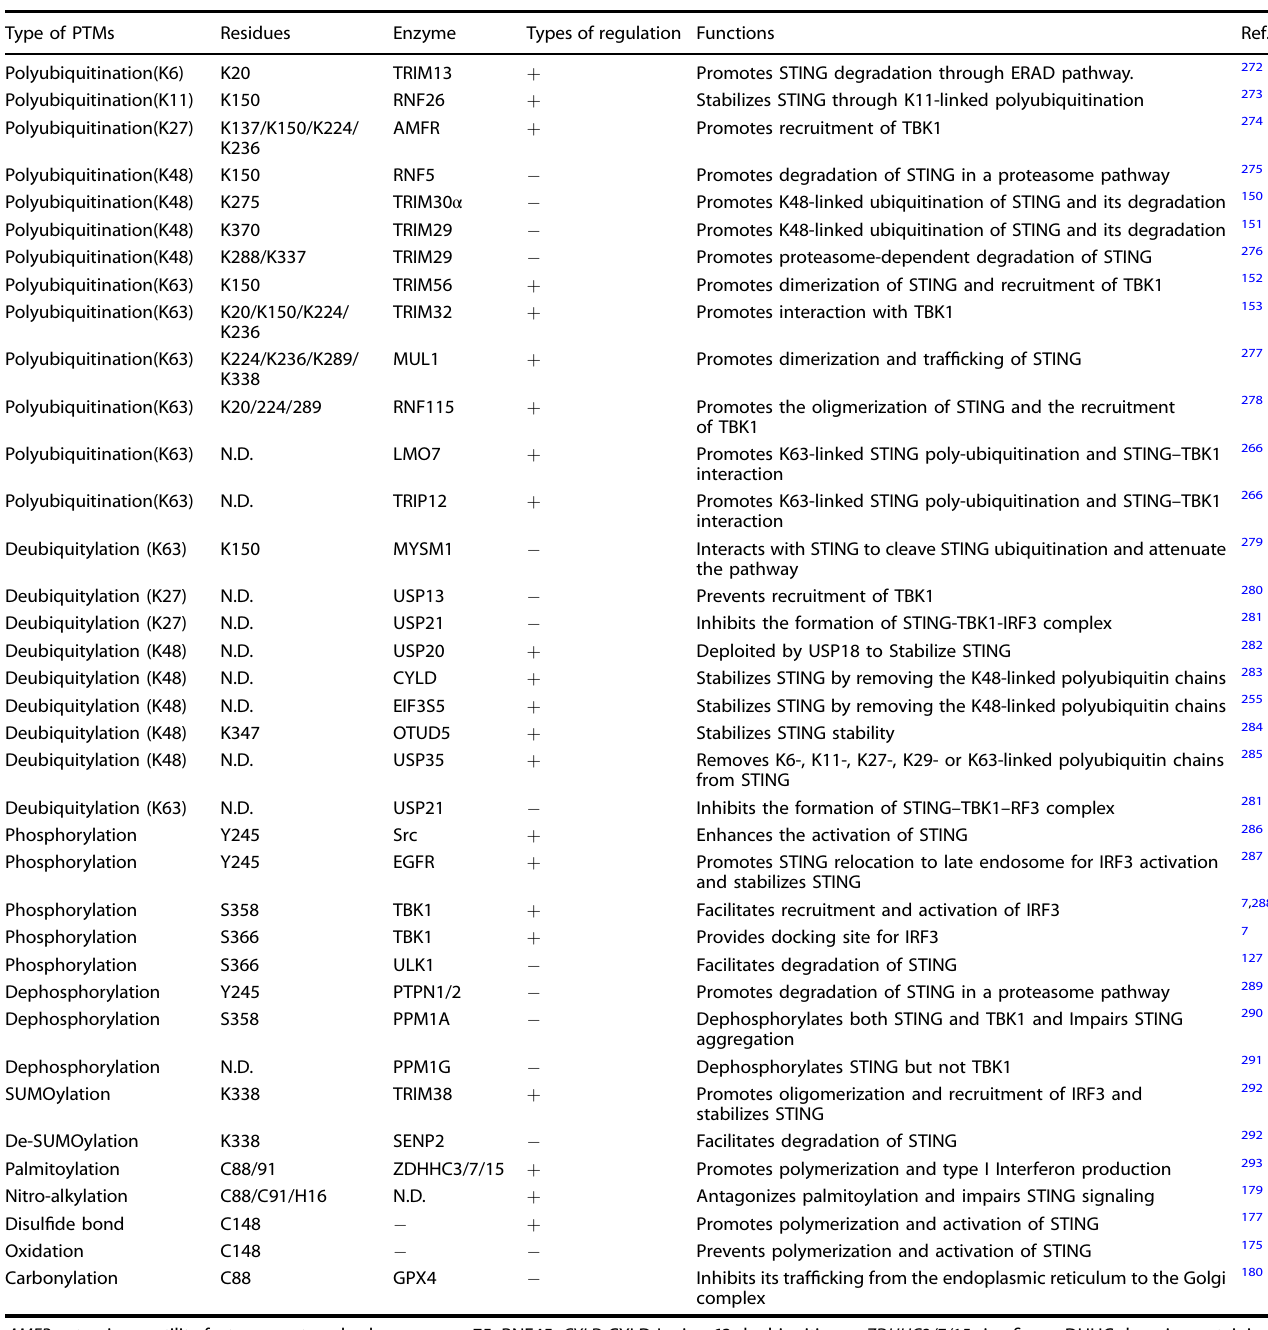
Table 2. STING post-translational modi fi